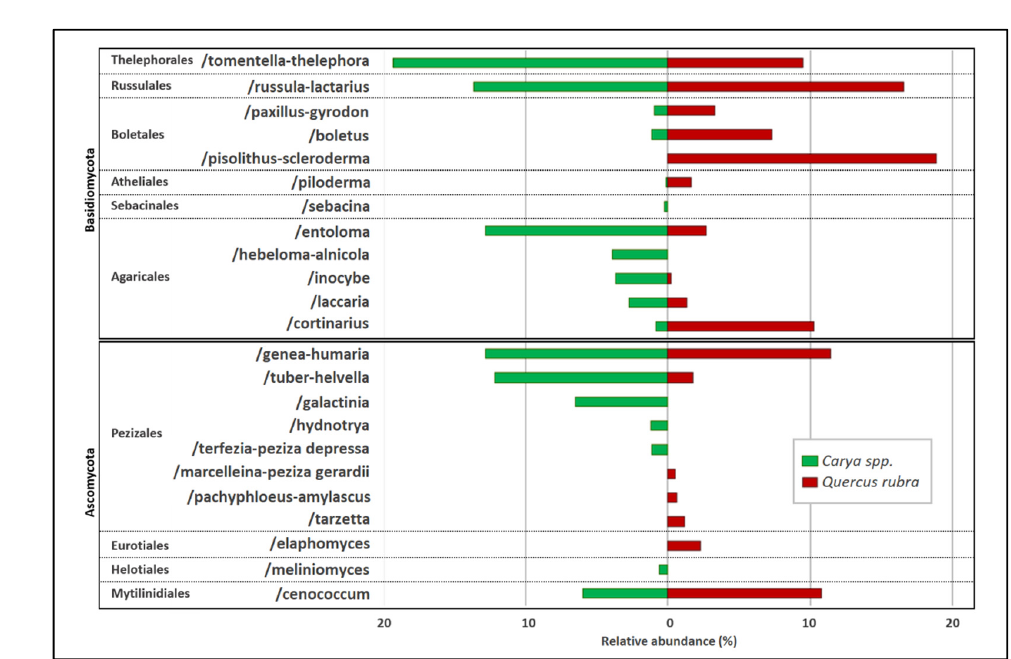
Figure 2. Relative abundance of ECM phylogenetic lineages of fungi on Carya and Q. rubra roots. Out of 23 ECM phylogenetic lineages, 12 lineages were common for both Q. rubra and Carya , 5 were found only on Q. rubra , and 6 lineages were found only on Carya roots (Figure 2). Lineages /russula-lactarius, /tomentella-thelephora, /genea-humaria, and /cenococcum were represented by a similar abundance of ECM tips on Q. rubra and Carya roots. The largest difference was observed among lineages from Boletales (/pisolithus- scleroderma; /boletus; and /paxillus-gyrodon), which were represented by 29.5% of ECM tips on Q. rubra roots and 2.1% of ECM tips on Carya roots (Figure 2). The long-distance exploration type (formed by Boletales fungi) and medium-distance exploration type of ectomycorrhizae were most abundant on Q. rubra (52.9% of ECM roots). On the